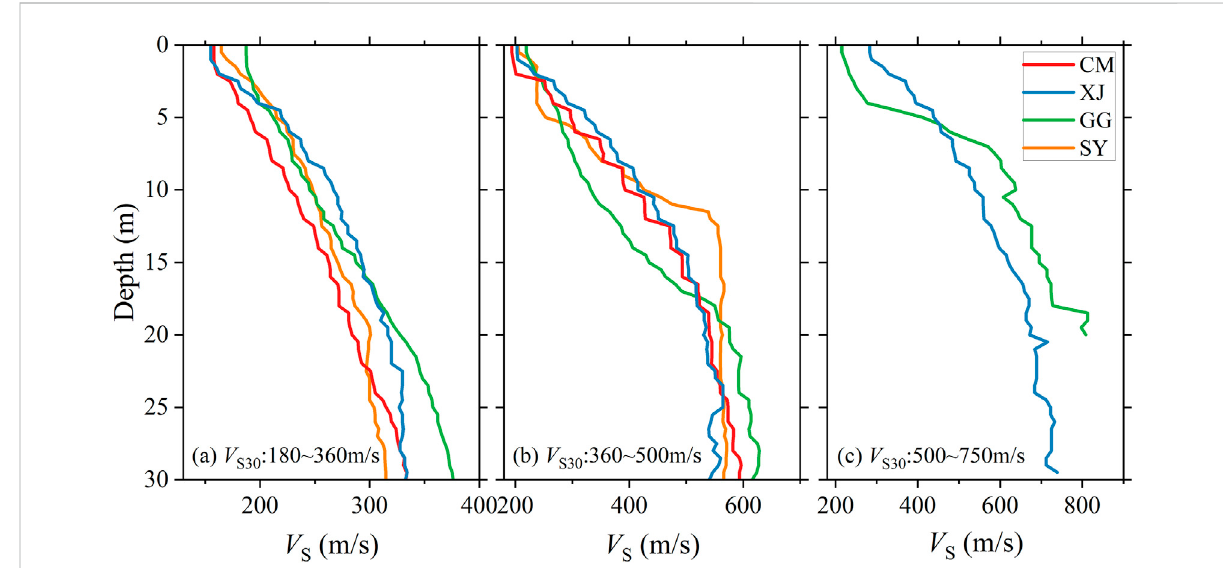
FIGURE 7 Median V S pro fi les for sites belonging to each V S30 -based category in the four regions considered in this study: (A) category C1 for V S30 = 180 – 360 m/s, (B) category C2 for V S30 = 360 – 500 m/s, and (C) category C3 for V S30 = 500 – 750